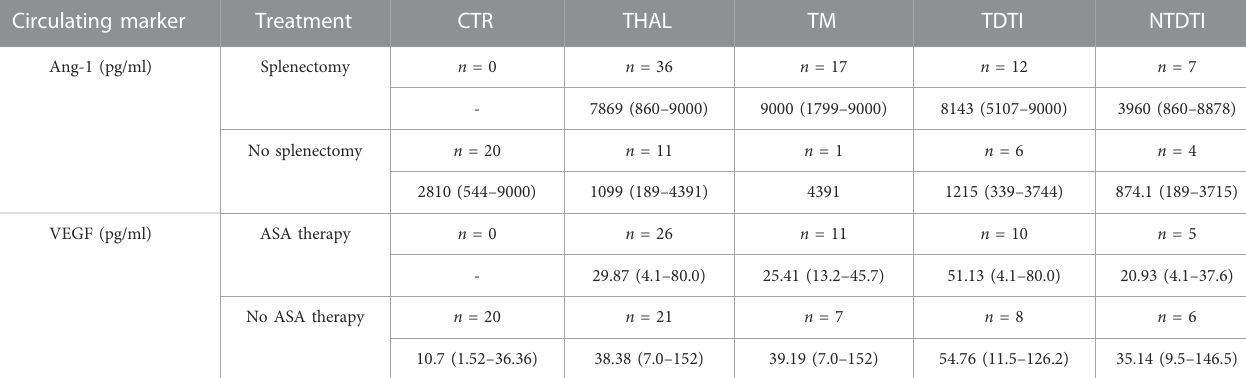
TABLE 4 Circulating angiopoietin-1 and VEGF levels in plasma from healthy subjects and from patients divided according to the occurrence/absence of splenectomy and to therapy with aspirin, respectively. Data are reported as median, and range values. Circulating marker